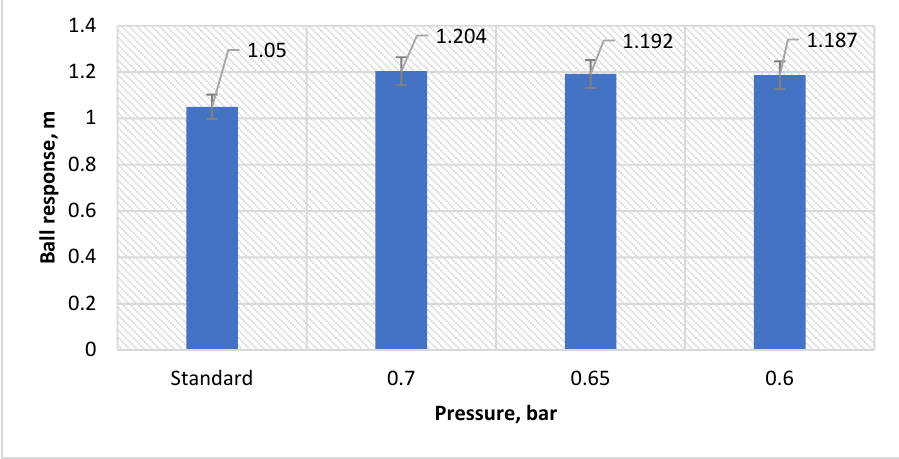
Figure 7. Influence of the width and thickness of the specimen on the modulus of elasticity.